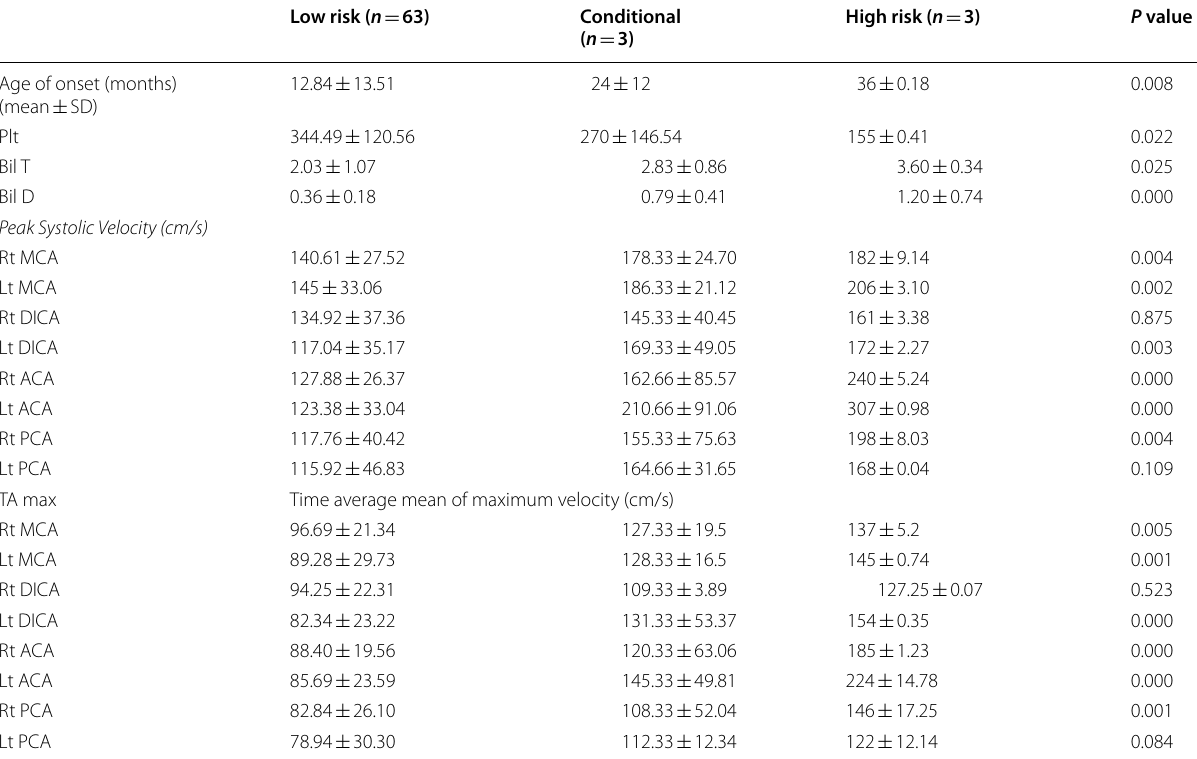
Table 4 Comparison between groups according to risk of stroke regarding demographic, hematological, biochemical and radiological